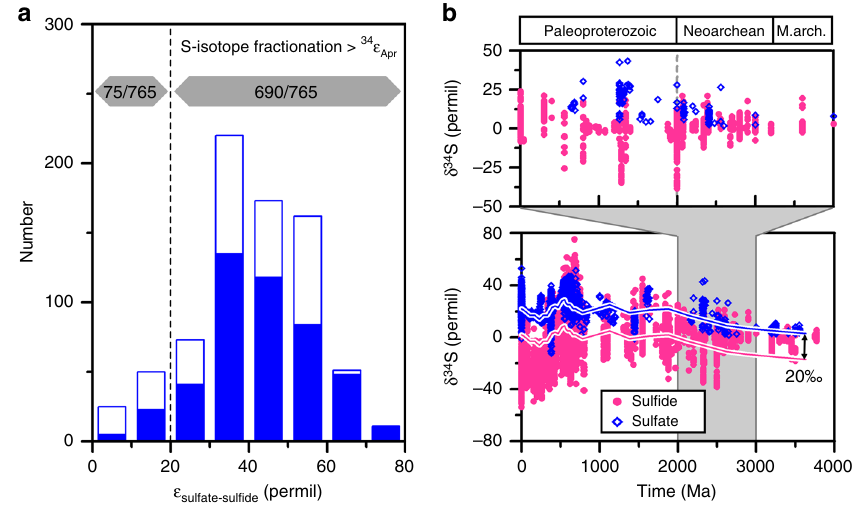
Fig. 4 Comparison between the sulfur isotope effect of APS reductase and the sulfur isotope data compiled from previous studies of environmental and sedimentary samples. a Histogram showing the distribution of sulfur isotope fractionation values reported from modern terrestrial (open bars) and marine environments ( fi lled bars) (Supplementary Data 1). Most of the measured fractionations from both environments exceed the 20 ‰ sulfur isotope effect of APS reductase (dashed line). b Compiled records of sulfate and pyrite δ 34 S values from sedimentary strata. The data are taken primarily from two previous compilations 5,61 supplemented with the Archean δ 34 S data published during the last decade (Supplementary Data 2). Blue and red lines represent the seawater sulfate δ 34 S trend 61 and the identical curve displaced by 20 ‰ , respectively. The upper panel shows an expanded view of the sedimentary sulfur isotope record from the Archean to Paleoproterozoic; the dashed line in the upper panel represents 2.5 Ga. Note that the sulfur isotopic offset between sulfate and sul fi de greater than 20 ‰ is scarce in the sedimentary rocks older than 2.5